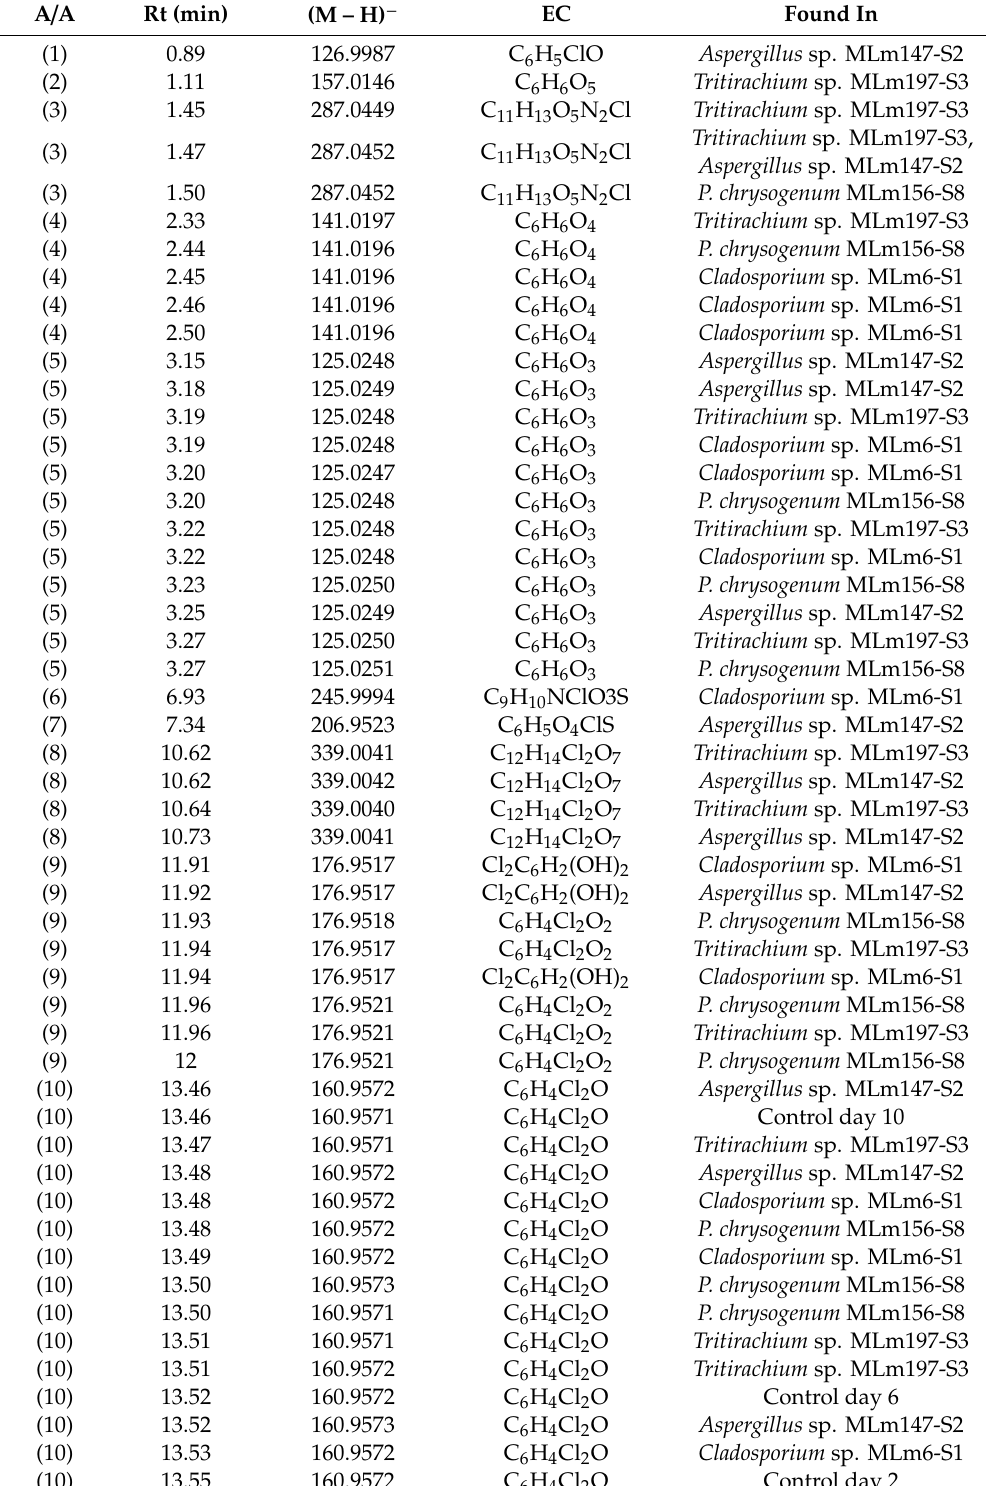
Table 2. 2,4-DCP metabolites traced only in DCP-treated cell cultures. Rt = retention time; (M – H) − = m / z of the pseudomolecular ion; EC = the elemental